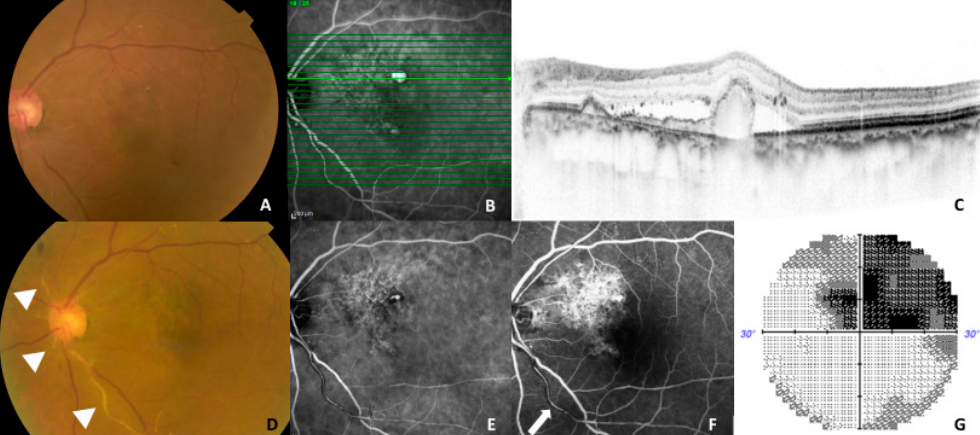
Figure 5. A representative case (77-year-old woman) showing an adverse event during the follow-up. ( A – C ) At baseline, fundus photography showed an orange-red lesion superior to the fovea (left), a horizontal optical coherence tomography (OCT) scan demonstrated a double layer sign and retinal pigment epithelial protrusion (left) corresponding to the branching vascular network and a large polypoidal lesion on indocyanine angiography (ICGA) (middle). Whitened retinal vessels as indicated triangles were seen on color fundus photography ( D ) and a residual polypoidal lesion was seen on ICGA. ( E ) Partial perfusion as indicated a white arrow was seen in the inferior arteriole arising from the optic disc on fluorescein angiography 1 month after the third brolucizumab injection. ( F ) Almost half of the superior visual field defects were detected on the Humphrey visual field analyzer 30-2 program. ( G ) BCVA in the left eye was maintained at 0.7, in the decimal format, as was the baseline BCVA.